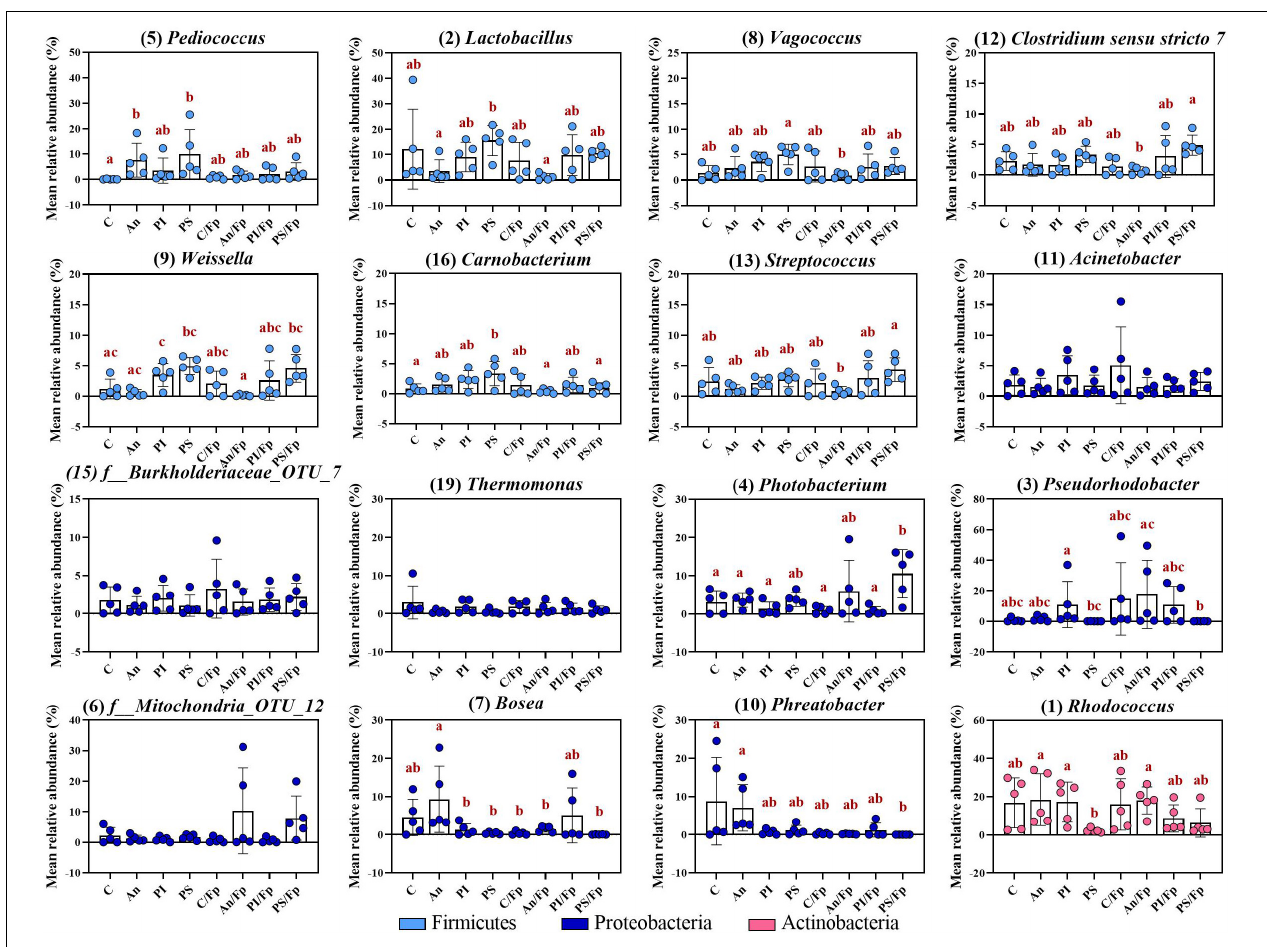
FIGURE 12 | Top-13 most abundant, plus three additional genera, selected among the top-30 33 dpi in fish fed with control, antibiotic, phage-immobilized and phage-sprayed feed with (C/Fp; An/Fp; PI/Fp; PS/Fp) and without (C; An; PI; PS) bacterial exposure. The selection of the additional genera was based on previously observed abundances (among top-13 at day -1). The number in parenthesis states the position of the genus in the ranking. Values represent the mean and SD of five samples. Differences are tested by ANOVA or Kruskal–Wallis ( P -values are adjusted for multiple comparison). When significant, differences are presented with different red letters. See Supplementary Table 13 for more information on the top-30 most abundant genera at day